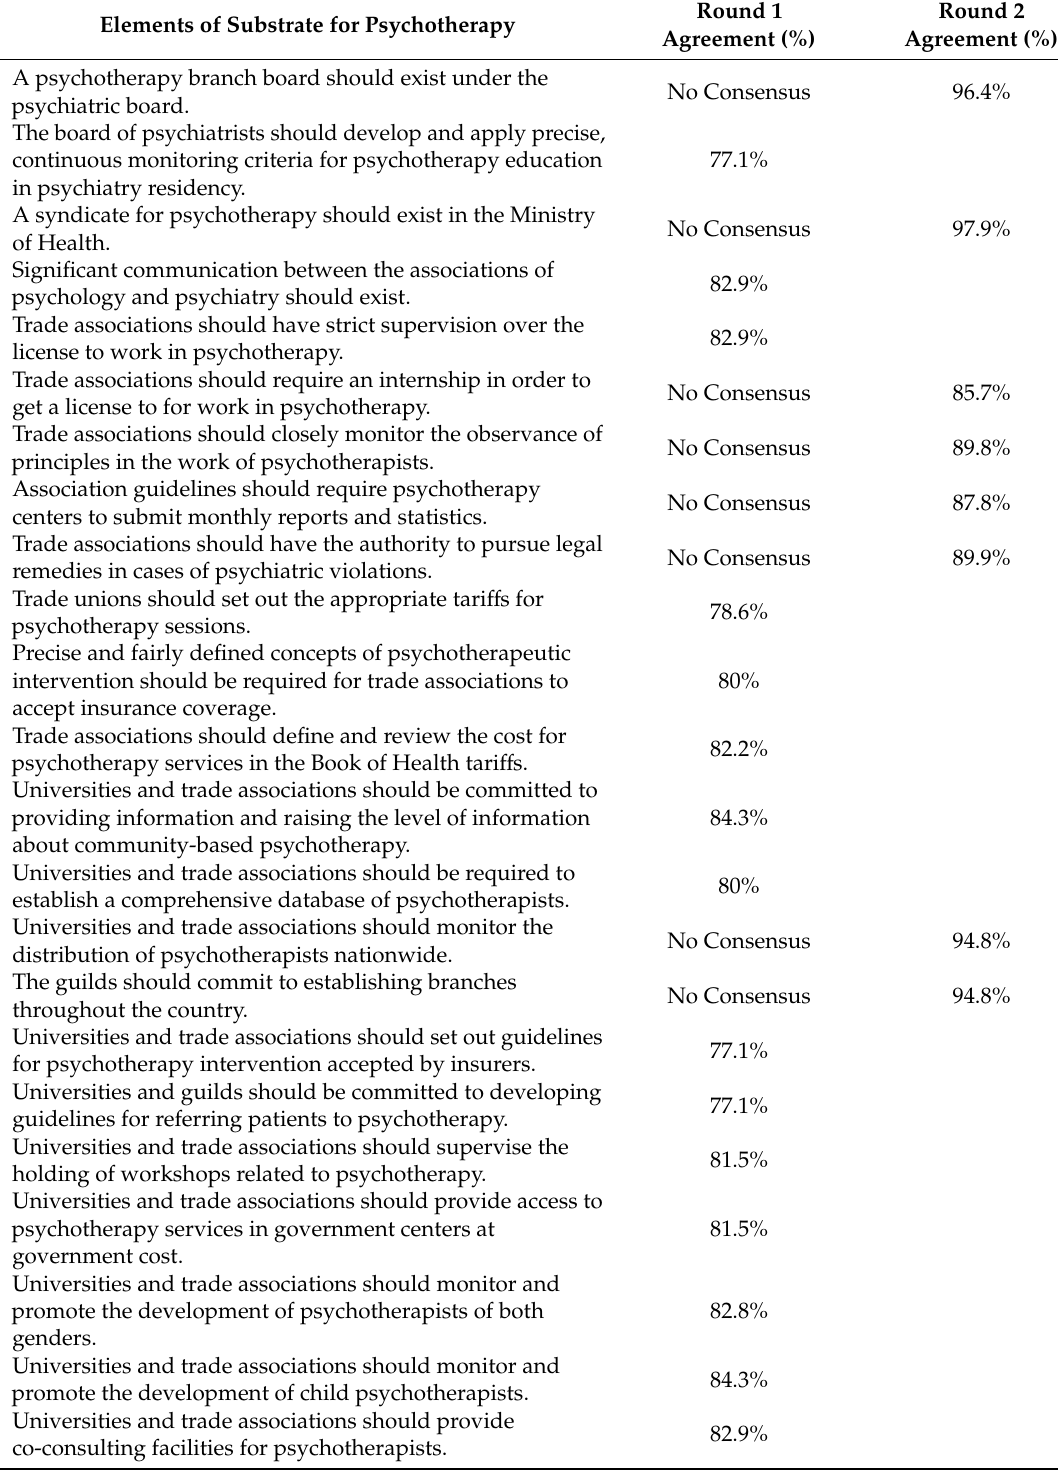
Table 5. Results of rounds 1 and 2 for substrate for